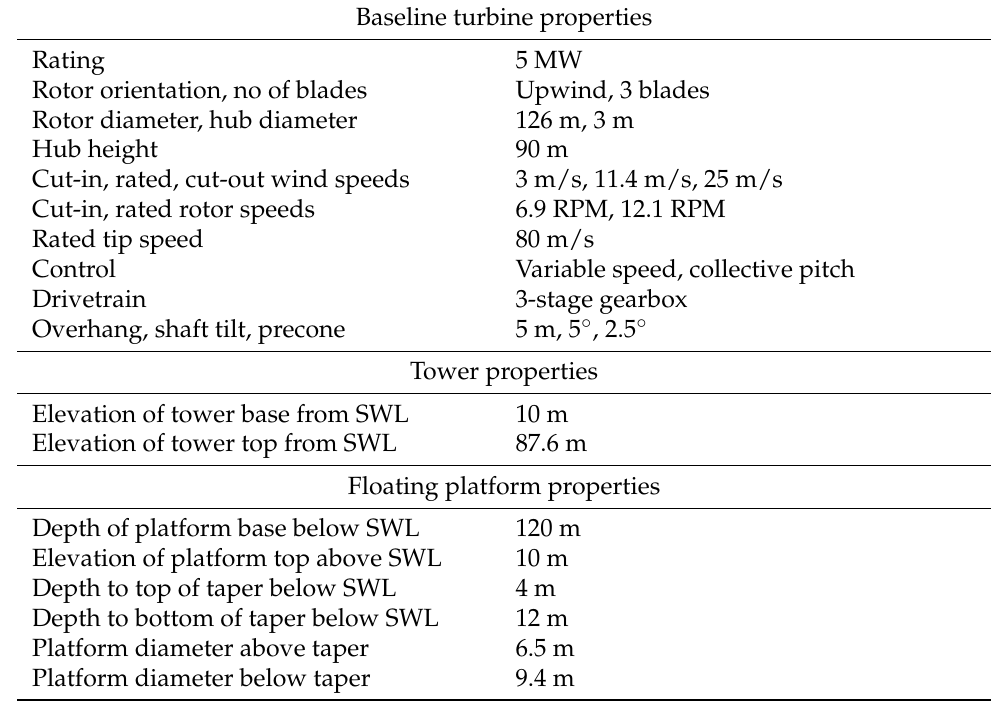
Table 1. Basic properties of the NREL 5 MW baseline offshore wind turbine.